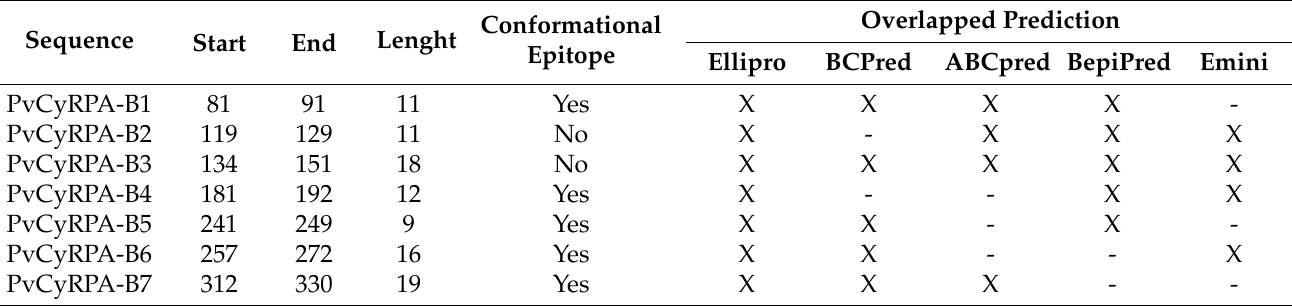
Table 5. B-cell epitope mapping of PvCyRPA (Salvador-1 Strain).